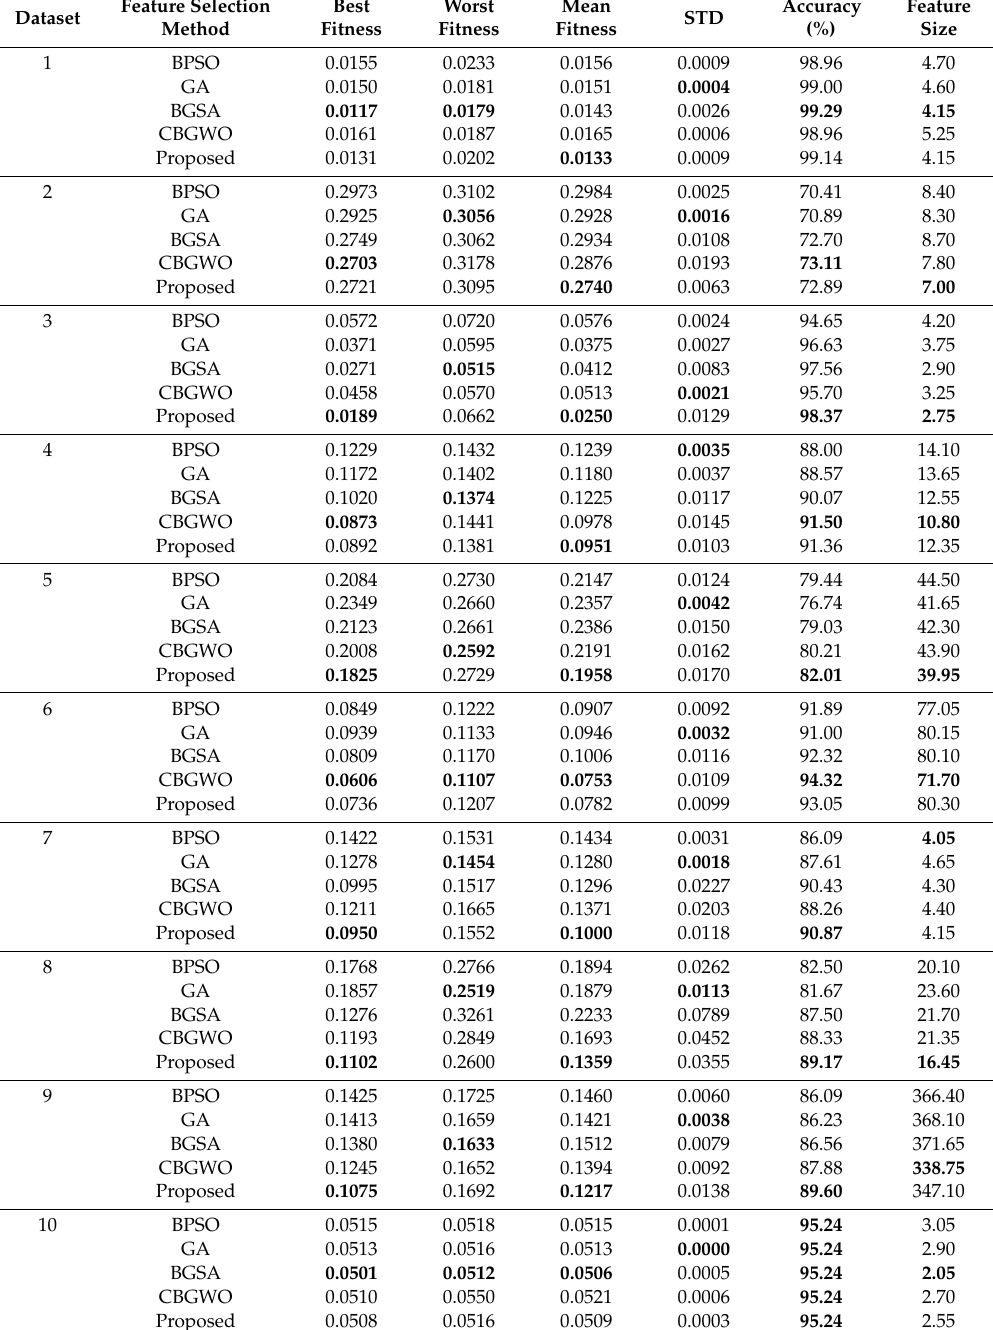
Table 3. Experimental results of five feature selection methods for 10